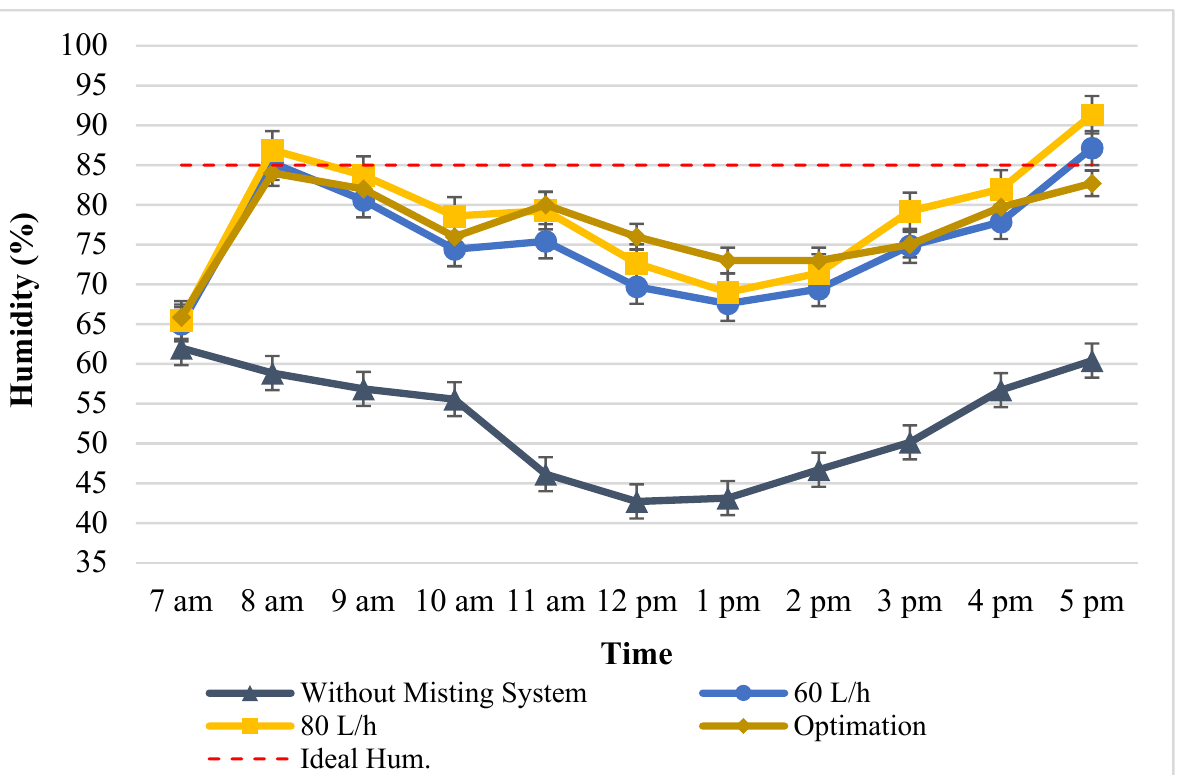
Figure 8. Humidity in the greenhouse using the optimum flow rate of water misting.